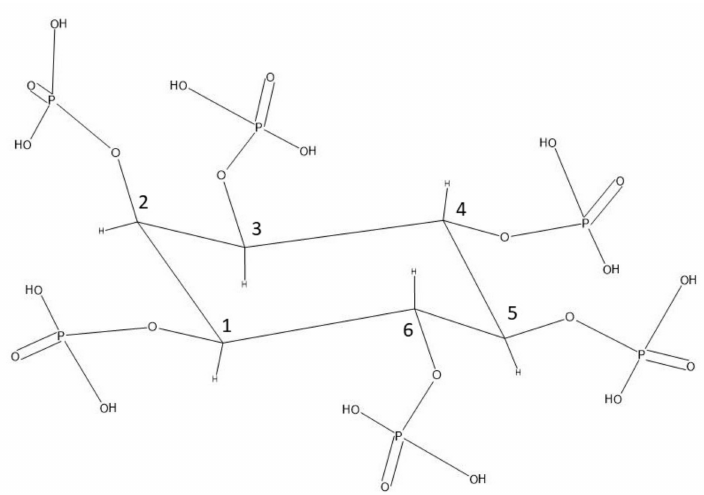
Figure 1. Phytate molecule in the 1ax / 5eq conformation. Redrawn in ACD / ChemSketch after [3].